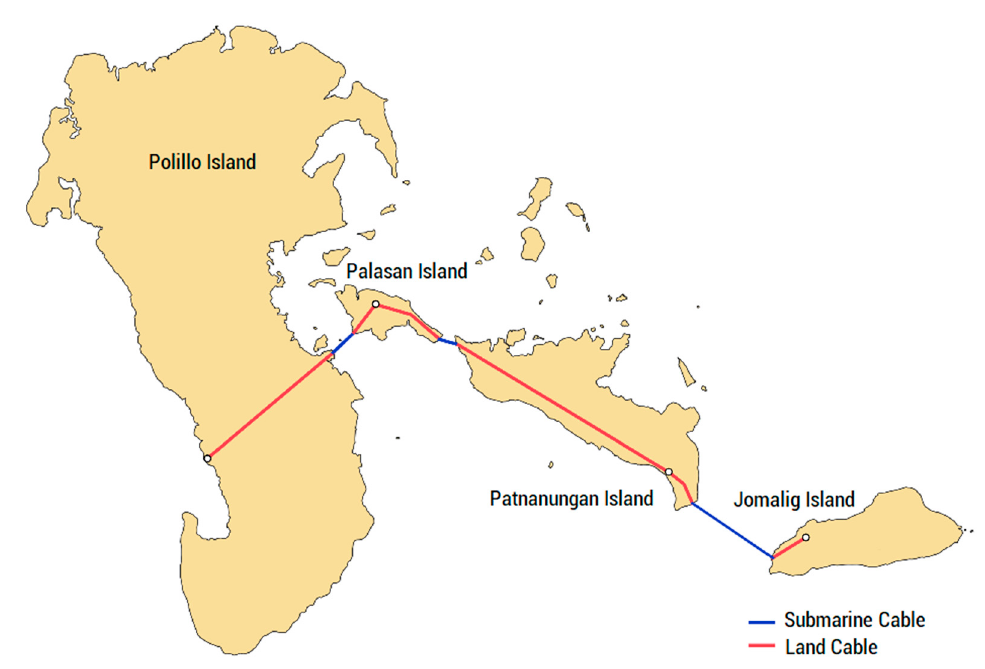
Figure 5. Optimized land and submarine cable routes between islands.